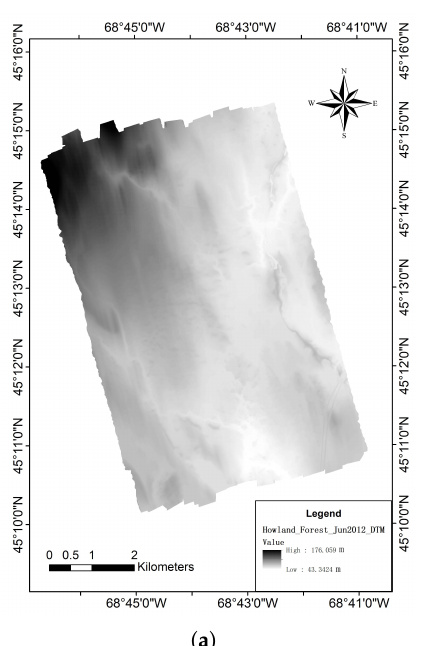
( a ) ( b ) Figure 3. The 1 m resolution DTM and CHM of the study site driven from G-LiHT. ( a ) The DTM from G-LiHT. ( b ) The CHM from G-LiHT.